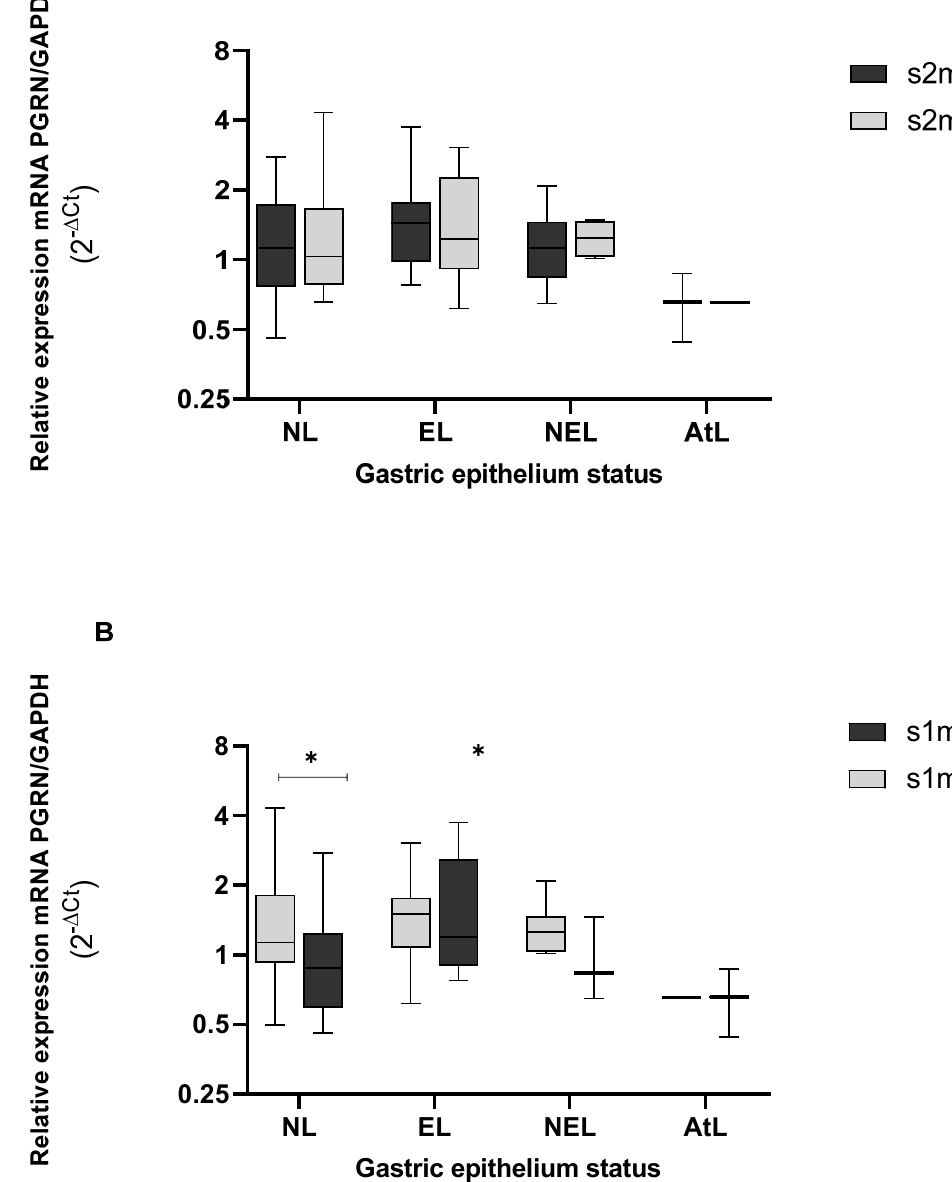
Figure 8. Genic expression of PGRN in the different status of gastric tissue colonized with H. pylori vacAs2m2 + , ( A ) and vacA s1m1 + . ( B ) NL = epithelium without lesions; EL = erosive lesions; NEL = non-erosive lesions; AtL = atrophic lesions. Calculated GRN expression values by the formula 2 −Δ Ct , being Δ Ct = Ct of GRN − Ct of GAPDH . The virulence of H. pylori was detected by amplification of the vacA gene, s and m alleles, by the PCR method, and the PCR polymorphic restriction assay-RFLP for confirmation of vacA s and m alleles, visualized on agarose gel (Cleaver Scientific, Rugby, UK). The status of the gastric tissue was determined according to the report of the endoscopic observa- tion. The data were compared by a non-parametric Kruskal–Wallis and Mann–Whitney tests for comparison between two variables. * Statistical significance p < 0.05.